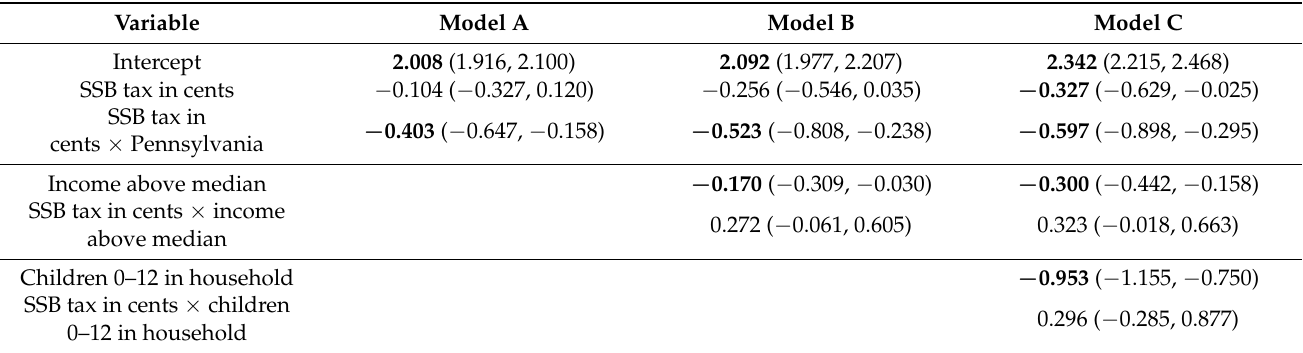
Table 2. Multivariate Models of Carbonated Soft Drink Purchasing by Study Households.